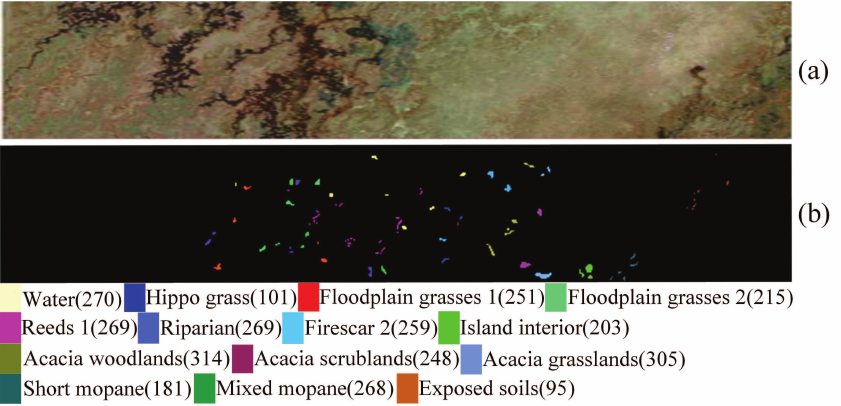
Figure 7. Botswana hyperspectral image. ( a ) False-color image. ( b ) Ground-truth